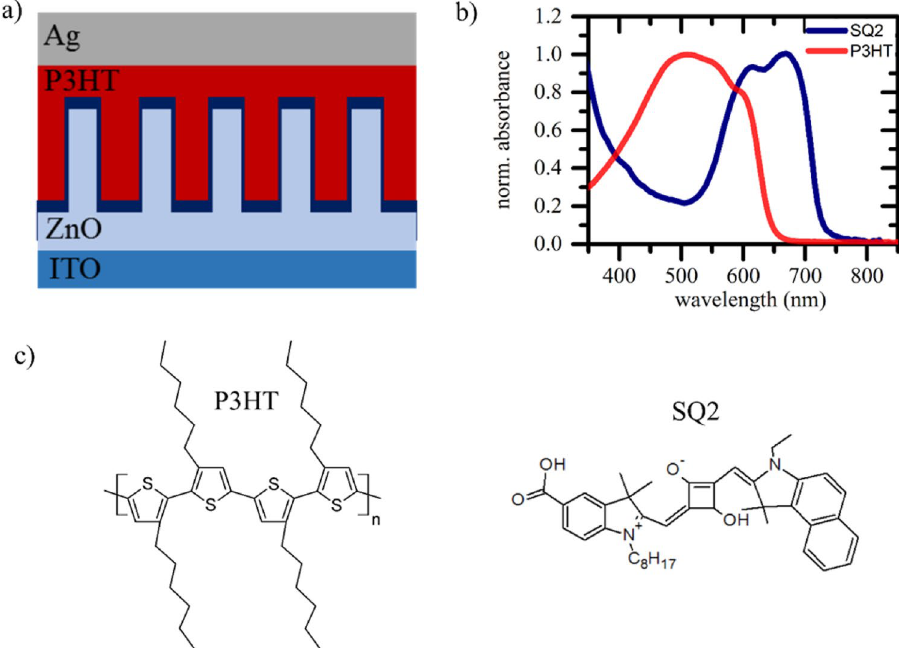
Figure 1. ( a ) Schematic drawing of the investigated hybrid solar cell employing ZnO nanowires with variant Sn doping concentrations. The ZnO surface is decorated with a SQ2 dye monolayer (indicated in dark blue). ( b ) Normalized absorbance spectra of the donor polymer P3HT and the dye molecules SQ2 acting as photoactive materials. Their chemical composition is shown in ( c